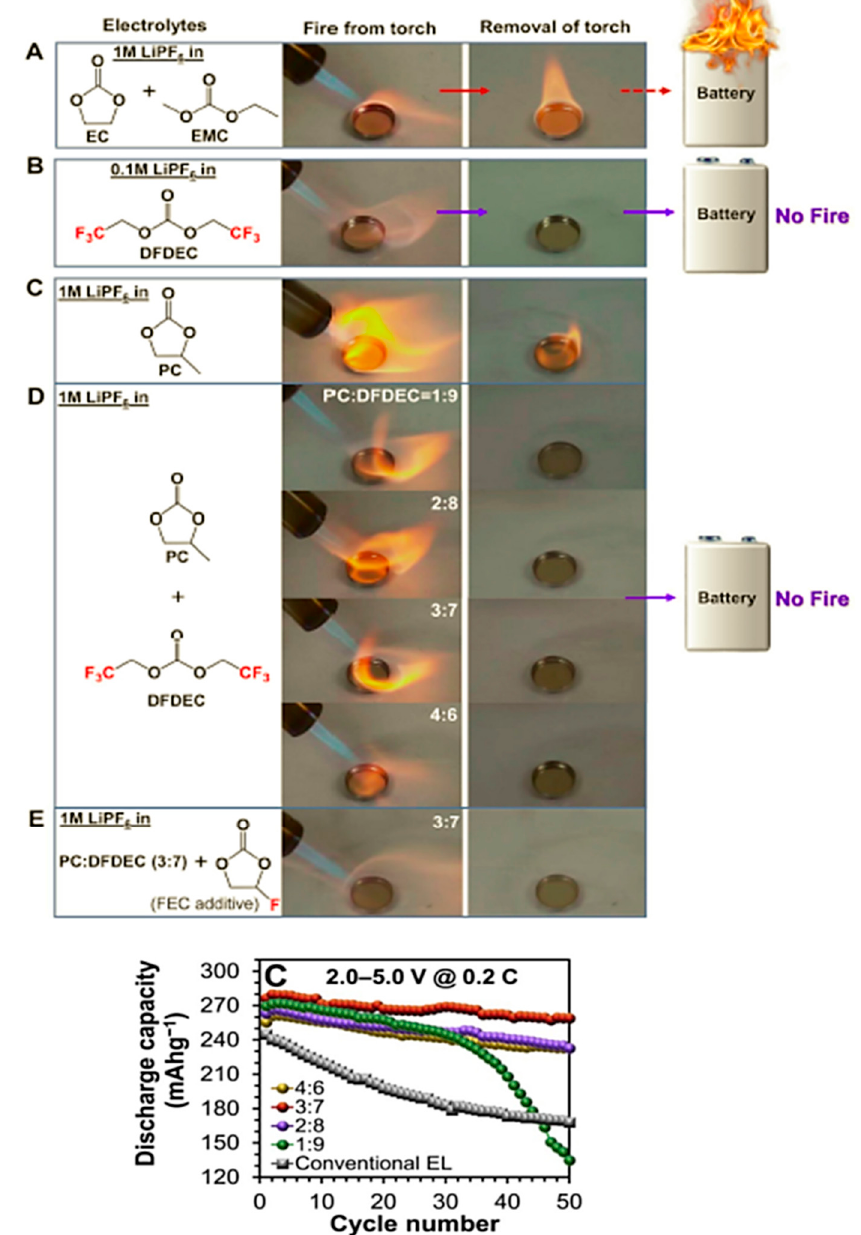
Figure 6. Fire test results for ( A ) conventional electrolyte of 1 M LiPF 6 /EC:EMC (3:7 vol ratio), ( B ) 0.1 M LiPF 6 /di-(2,2,2 trifluoroethyl) carbonate (DFDEC), ( C ) 1 M LiPF 6 /propylene carbonate (PC), ( D ) designed electrolytes of 1 M LiPF 6 /PC:DFDEC at volume ratios of 1:9, 2:8, 3:7, and 4:6, and ( E ) 1 M LiPF 6 /PC:DFDEC (3:7) with 1 wt.% FEC additive. The charge–discharge cycling performance is shown below [28]. Reprinted with permission by Elsevier from Non-flammable organic liquid electrolyte for high-safety and high-energy density Li-ion batteries; H. Quang, H. Lee, E. Hwang, Y. Kwon, and S. Song, J. Power Sources, ©